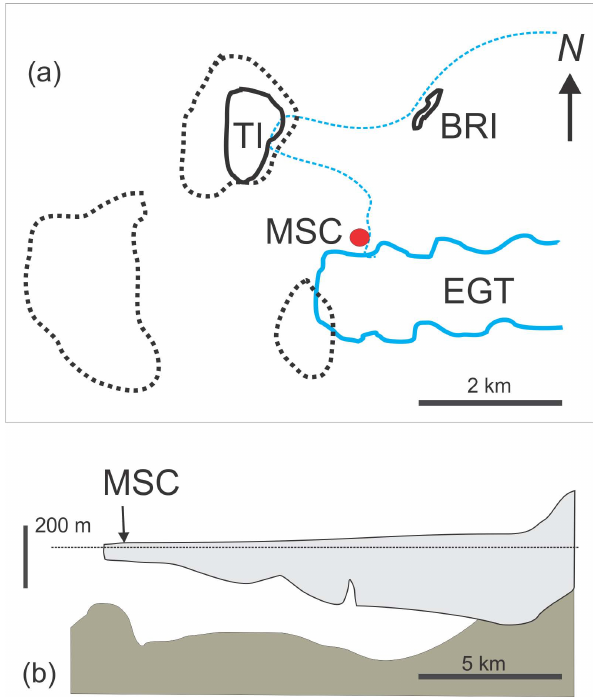
Fig. 3. (a) The sampling locale including the microstructure field camp (MSC), around 1000m east of the tip of the EGT. The black dotted lines highlight the known 100m contour whilst the blue dashed line shows a tongue of multi year fast ice (i.e. ice connected to the coast or glacier) extending out from the EGT to Big Razor- back Island. (b) A cross-section of the EGT simplified from DeLisle et al. (1989).